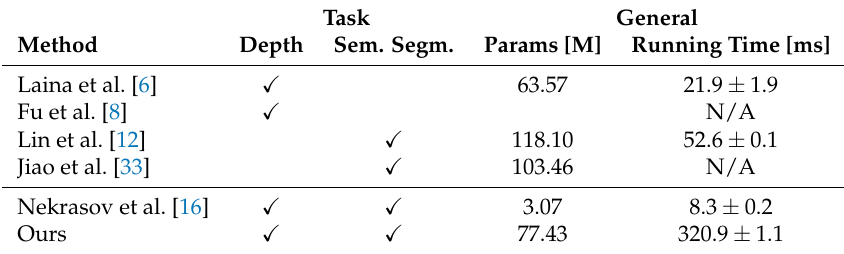
Table 2. Comparison of the number of parameters and running time. Previous approaches have publicly available codes. ‘N/A’ means that a 640 × 480 image resolution can not be taken as an input due to the design of networks or GPU